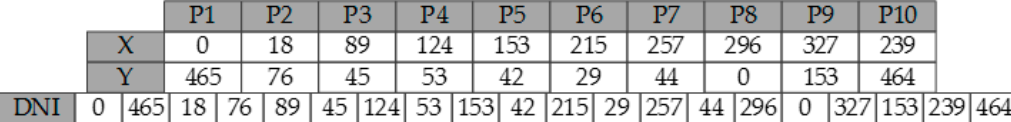
Figure 16. Dynamic neuron input arrangement.